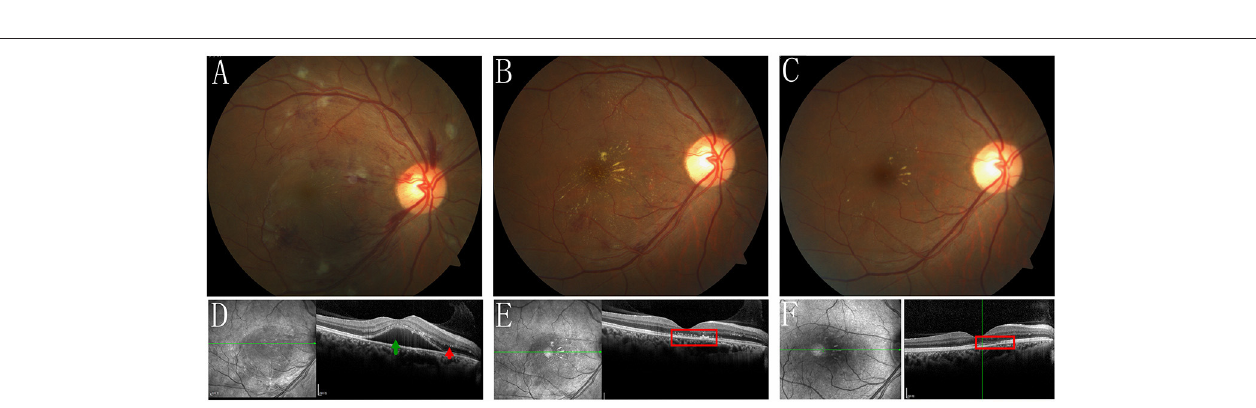
FIGURE 3 | Fundus photograph, and SD-OCT of the right eye during the follow-up. (A,D) 1 week follow-up, the IRF (red arrow) and SRD (green arrow) were reduced remarkably. (B,E) 1 month follow-up showed that the IRF and SRD were entirely resolved, however, the unusually punctate hyperreflection foci on the RPE level were still observed in the right eye’s macula by SD-OCT (red rectangle), indicating a previous elschnig spot (white arrow in Figure 1A and red arrows in Figures 1D–F ) and stellate exudates were observed in the right eye’s macula. (C,F) At the most recent follow-up, after 4 months, the fundus condition was further improved, however, interruption and disorganisation of the EZ and RPE on SD-OCT (red rectangles) and hard exudates were observed in the right eye’s macula.